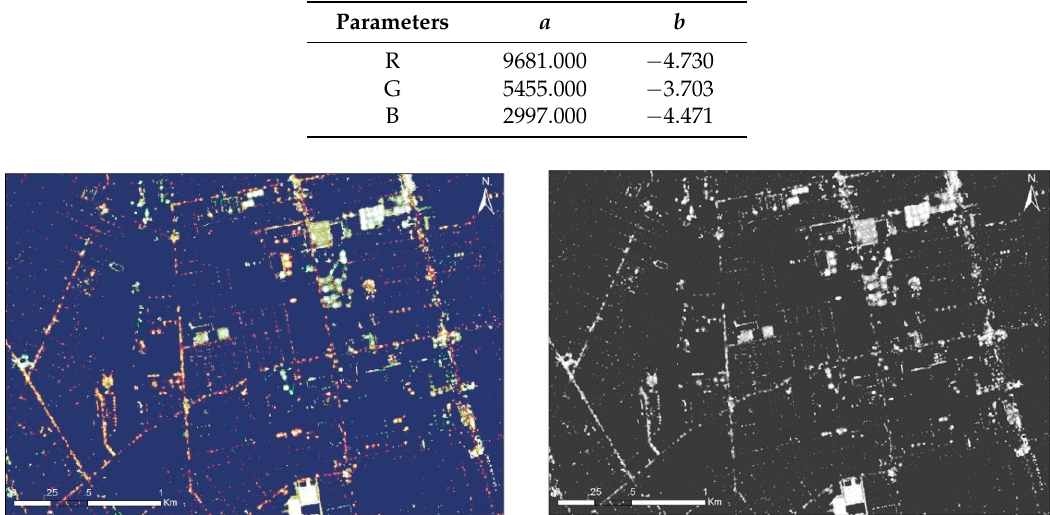
Figure5. The Jilin1-03 satellite night-time image with (a) RGB bands and the (b) grayscale layer.